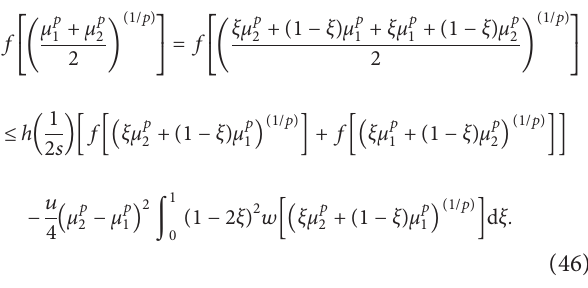
After integrating the above inequality with respect to “ ξ ” over [ 0 , 1 ] and multiplying both sides by w , which is a nonnegative and symmetric function about ( μ p